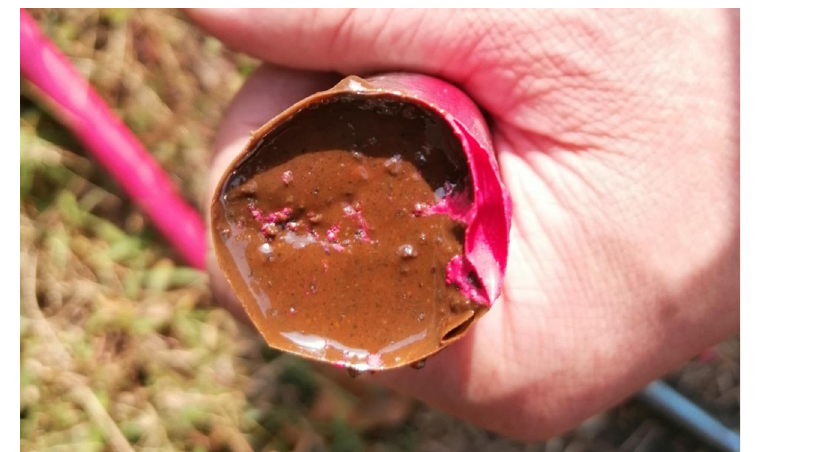
Fig 1. Cartridge resin anchoring agents using in coal mines.